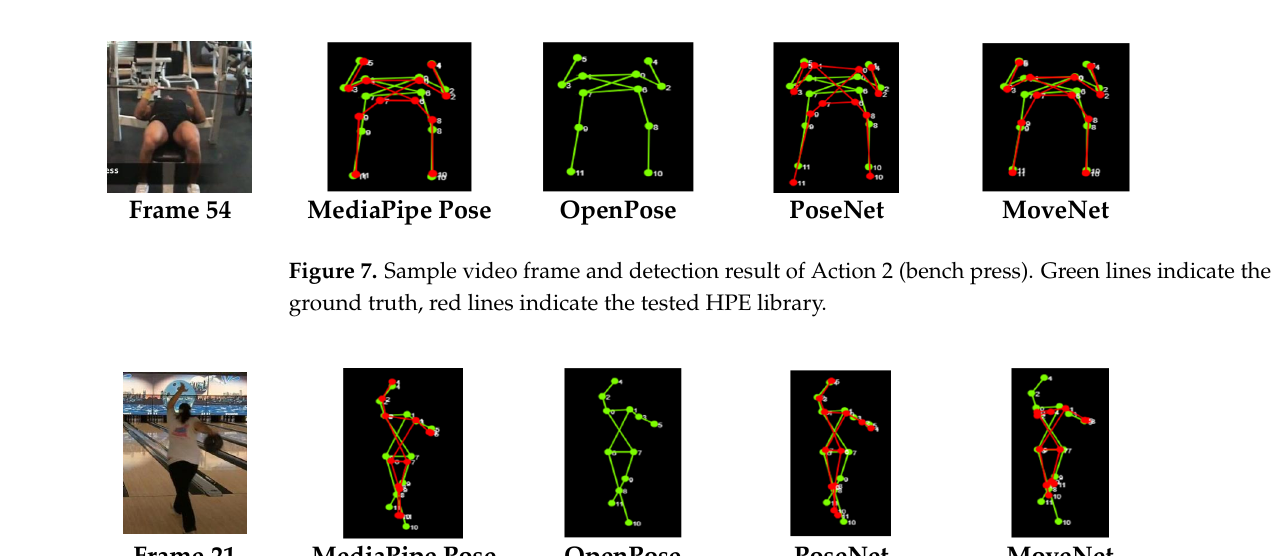
Figure 8. Sample video frame and detection result of Action 4 (bowling). Green lines indicate the ground truth, red lines indicate the tested HPE library.